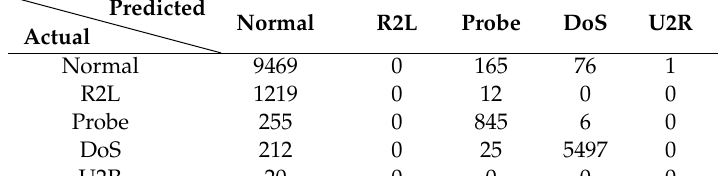
Table 5. Confusion matrix for modified NSL-KDD Test+.